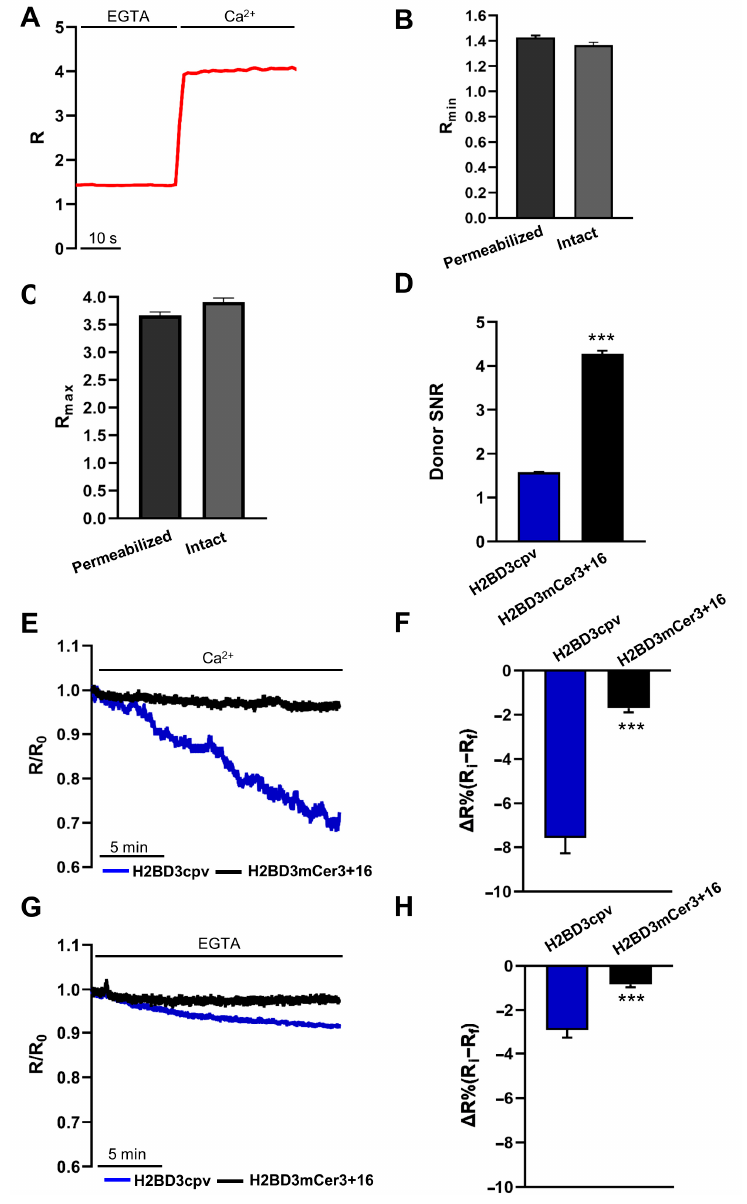
Figure 2. Biophysical characterization of nuclear Cameleons. ( A ) HeLa cells expressing H2BD3mCerulean3+16 were permeabilized with digitonin (100 µM) for 1 min in an intracellular medium containing EGTA (600 µM). Cells were then perfused with EGTA (600 µM) to record R min values and then with CaCl 2 (3 mM) to obtain R max values. Data are plotted as R/R 0 , as described in Materials and Methods. ( B ) The bar chart shows the R min values as mean ± SEM of n ≥ 38 cells calcu- lated in permeabilized (dark gray) or intact (light gray) HeLa cells expressing H2BD3mCerulean3+16. ( C ) The bar chart shows the R max values as mean ± SEM of n ≥ 31 cells calculated in permeabilized (dark gray) or intact (light gray) HeLa cells expressing H2BD3mCerulean3+16. ( D ) The bar chart shows the donor SNR of the two nuclear probes as mean ± SEM of n ≥ 53 cells for each condition. ( E , G ) The representative traces show R changes over time, normalized to the initial R (R i ), measured by illuminating the sample every second for 20 min in HeLa cells expressing H2BD3cpv (blue) or H2BD3mCerulean3+16 (black) in basal ( E ) or minimal ( G ) FRET condition. ( F , H ) The bar charts show the mean ± SEM of ∆ R% of the two probes, where ∆ R% is calculated as % of the reduction in R between its initial value (R i ) and its value after 20 min (R f ), obtained under basal FRET condition ( n ≥ 30 cells) ( E ) or minimal FRET condition ( n ≥ 29 cells) ( G ). *** p <